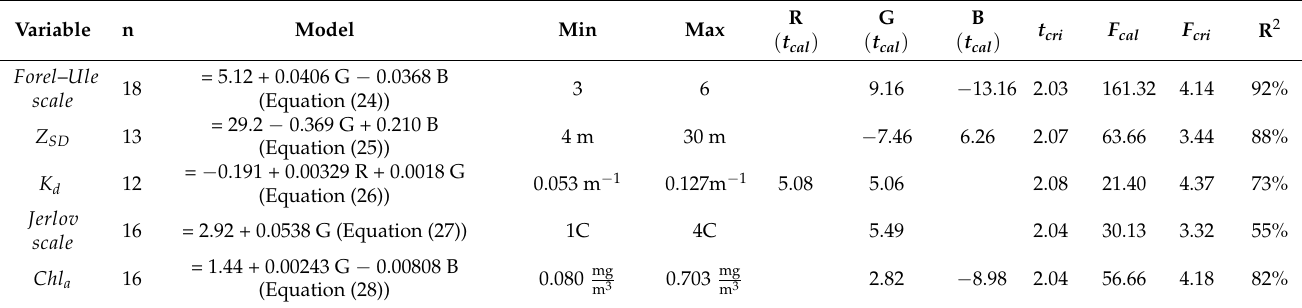
Table 6. Results of the stepwise multiple regression analysis for the coastal approach models ( α = 0.05 ) .